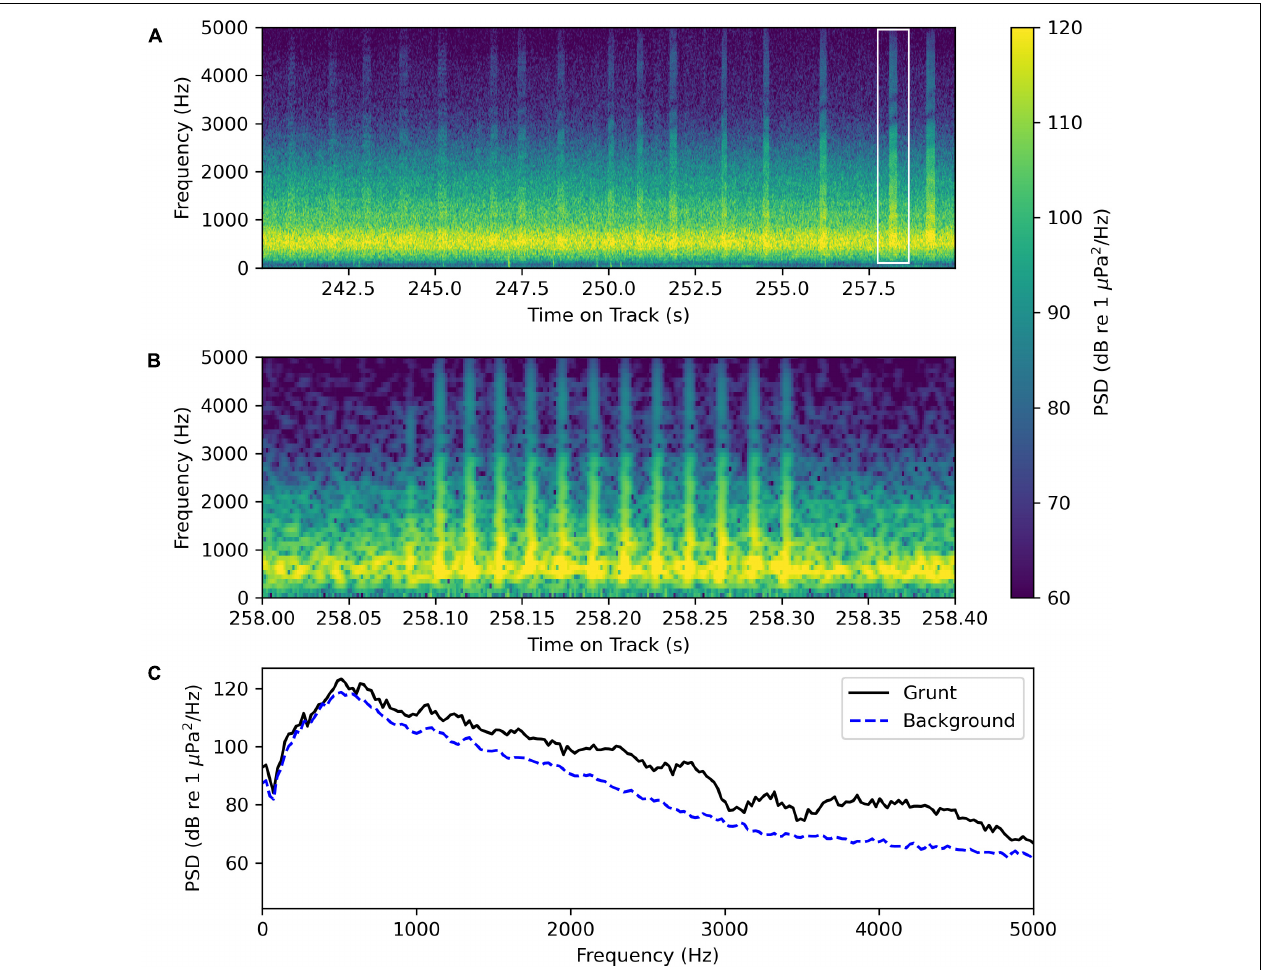
FIGURE 10 | Unknown “grunt” sound recorded by the wave glider Blackbeard at August-01 21:42:31 at latitude and longitude (34.580 348N, 76.635 034W) ( Supplementary Sound Clip Audio 3 ). (A) Spectrogram of a 20 s segment containing s sequence of “grunts.” The in the white rectangle indicates the region on the plot that was analyzed in the next panel (B) . (B) Spectrogram of the “grunt” sound in the rectangle in panel (A) using a 512-point FFT for greater time resolution. (C) Average power spectrum of the “grunt” sound shown in panel (B) was taken from 258.05 to 258.35 s and the average power spectrum of the background sound was taken from 256.5 to 257.5 s when no distinct “grunt” was detected. Both average power spectra were computed using 2048-point Hanning windows with an overlap of 1024